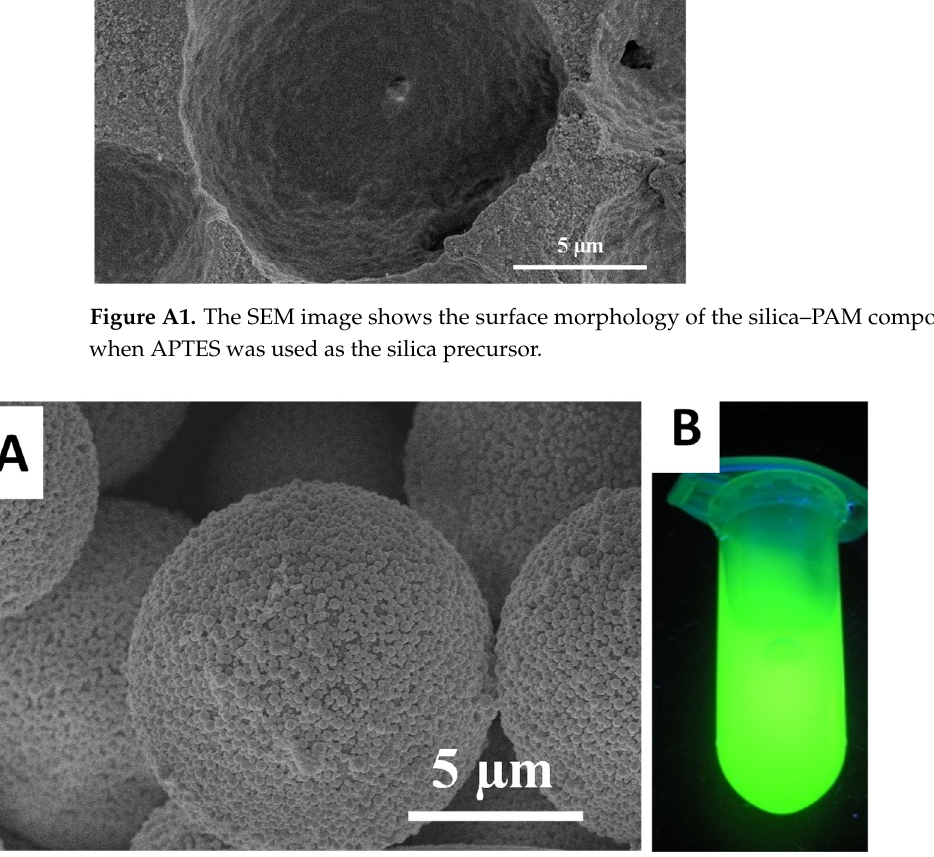
Figure A2. ( A ) The SEM image of fluorescent MPTMS particles and ( B ) the appearance of the MPTMS particles suspended in solution under the UV light at 365 nm.